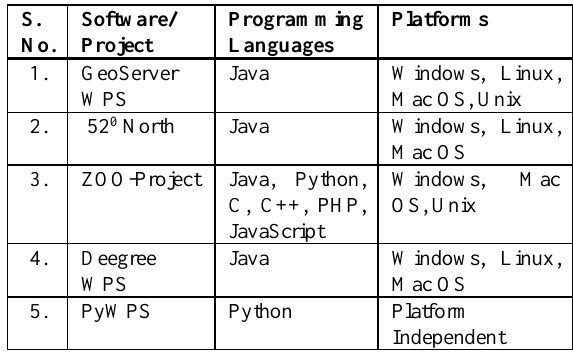
Table 1. OSS for WPS implementation on